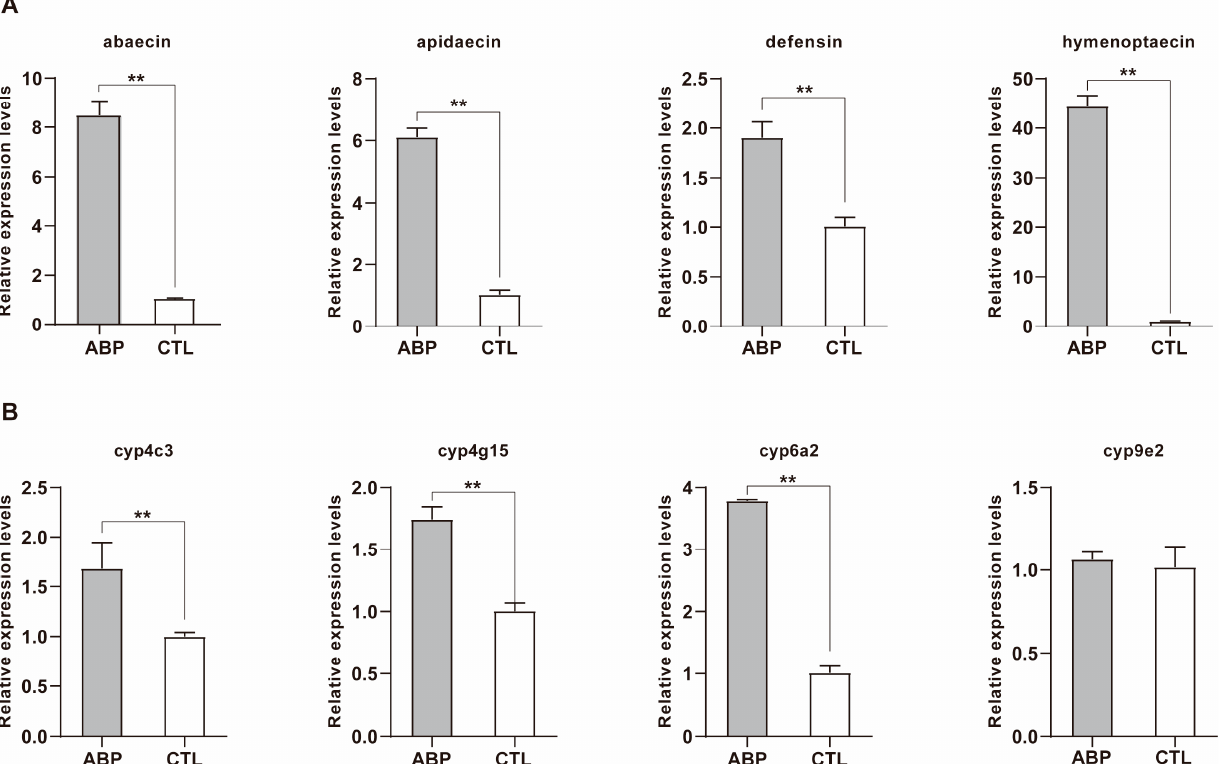
Figure 5. Relative expression of the ( A ) antimicrobial peptide family and ( B ) cytochrome P450-dependent monooxygenase genes of A. cerana foragers fed on ternary mixed fungicide (ABP) and 50% sucrose as control (CTL) for 10 days. Asterisks indicate differences between treatments via the t -test (** p < 0.01).